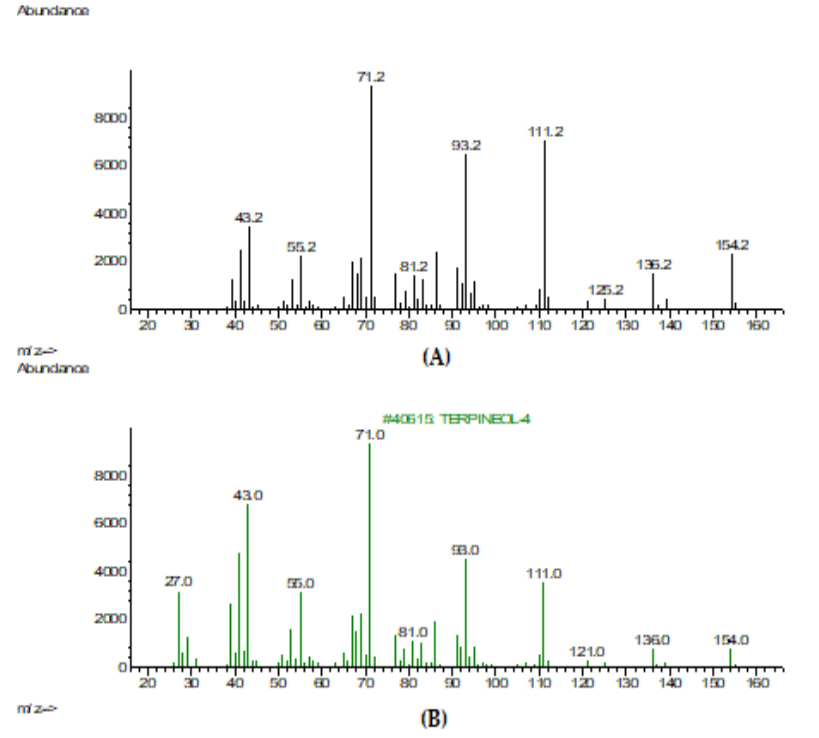
Figure 3. ( A ) Mass spectrum of terpinen-4-ol in TTO; ( B ) Mass spectrum of terpinen-4-ol from the NIST-2017 library. In addition, TTO contains 1,8-cineole in an amount of 5 to 10% as a secondary metab- olite to potentiate the action of other components [47]. The mass spectrum of 1,8-cineole is shown in comparison with a substance from the NIST-2017 library (Figure 4). The 1,8-cineole